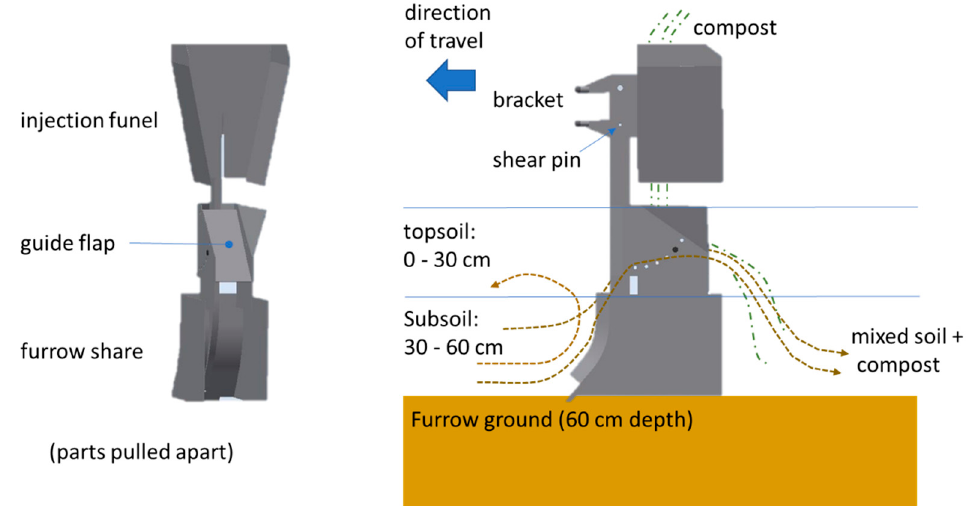
Figure 5. Injection tine. Components ( left ), material flow and mixing process ( right ) of compost (green) and subsoil (brown).